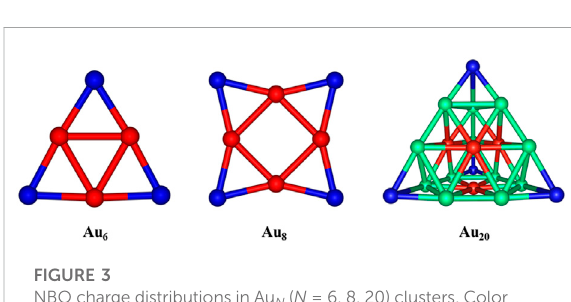
FIGURE 3 NBO charge distributions in Au N ( N = 6, 8, 20) clusters. Color range given in a.u. Are: blue: more positive than 0.06; red: more negative than